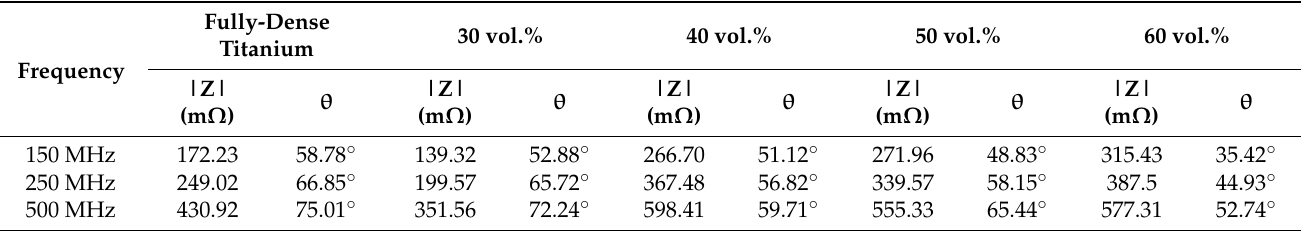
Table 1. Impedance modulus and phase values for different titanium samples with pore size 100–200 µ m before FS.